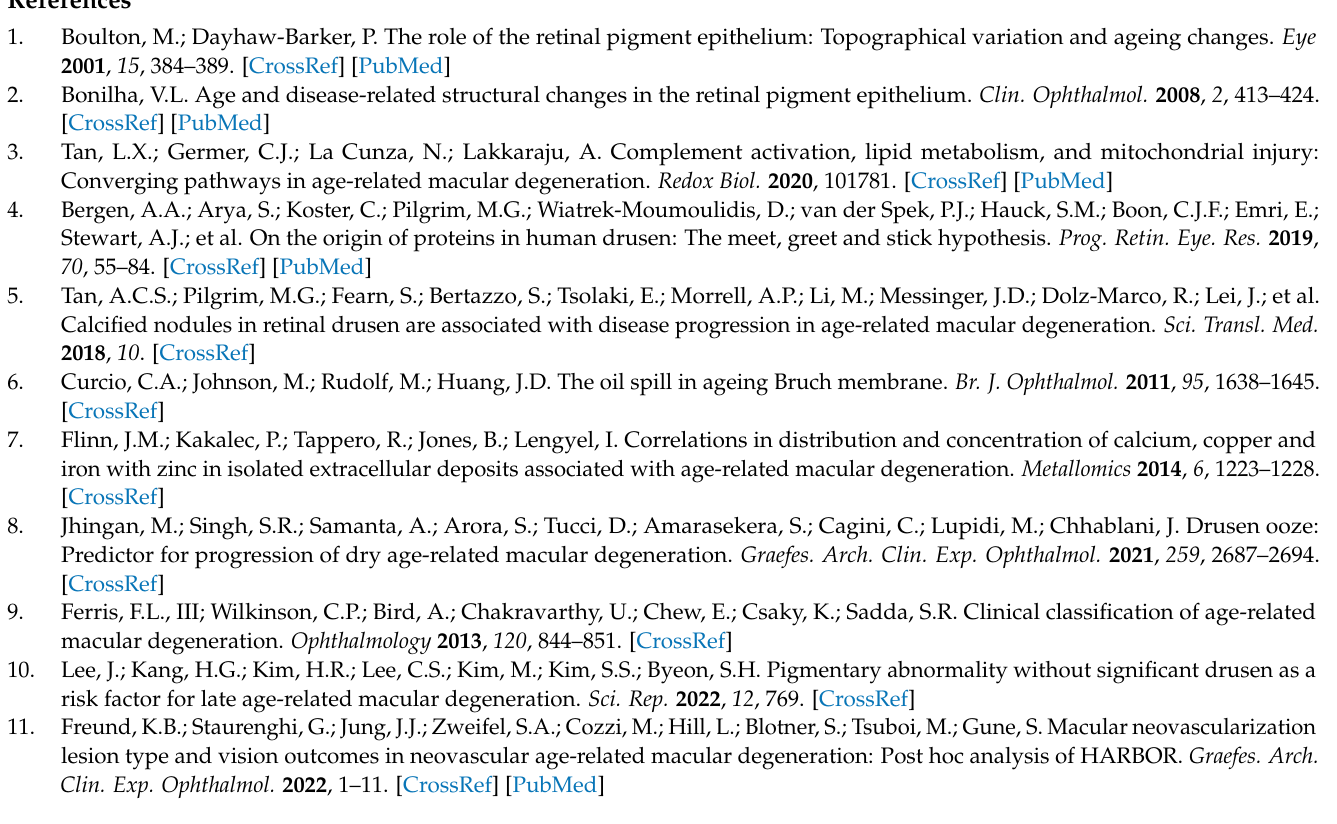
specific genes; Table S4: Supplementary Table S4 More and Less differentiated cells marker genes; Table S5: Pseudotime main trajectory genes; Table S6: Pseudotime main trajectory Gene Analytics; Table S7: Acute zinc differentially expressed genes list; Table S8: Acute zinc differentially expressed Gene Analytics; Table S9: Acute zinc pseudotime overlap Gene Analytics 01; Table S10: Acute zinc pseudotime overlap Gene Analytics 02; Table S11: AMD Genelists; Table S12: Overlapping genes for TGFB1 Upstream regulator table run from the 190 transiently expressed genes in the combined group of Pseudotime module 1 and